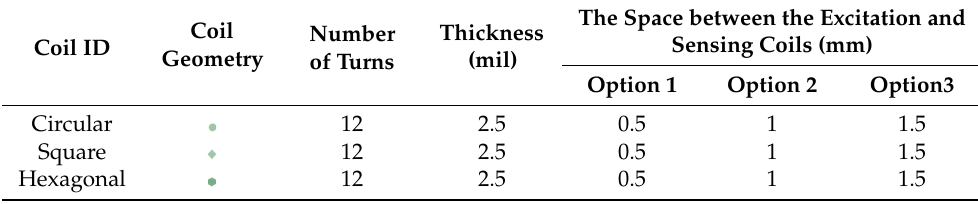
Figure 3. The various topologies of the modelled coils: square, circular and hexagonal, respectively. Table 2. The various features of the designed